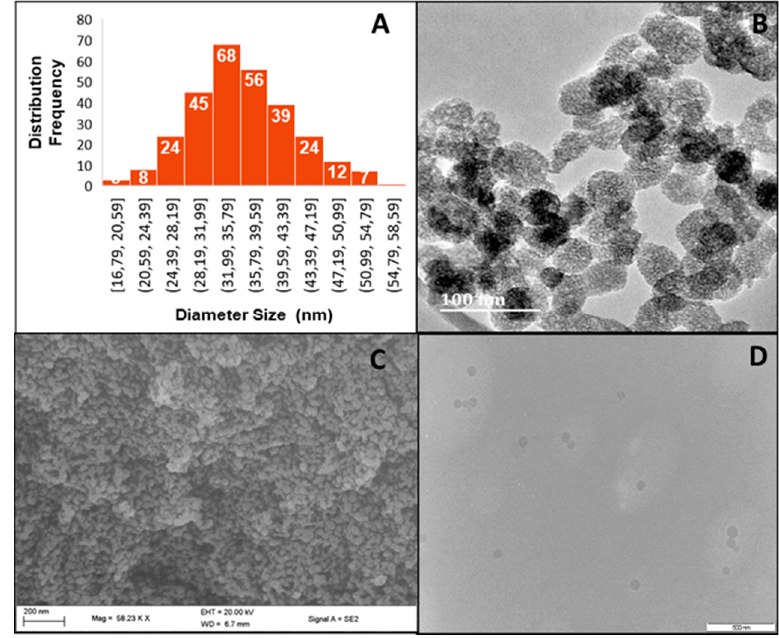
Figure 1. ( A ) Size distributions of MSNs from TEM images, ( B ) HRTEM image of MSN (Bar = 100 nm), ( C ) SEM image of 2% PCMSN (bar = 200 nm), and ( D ) DOX loaded 2% PCMSN (50 kV) (Bar = 500 nm.). Table 1. Size, PDI and zeta potential of all MSNs and DOX-loaded MSNs.